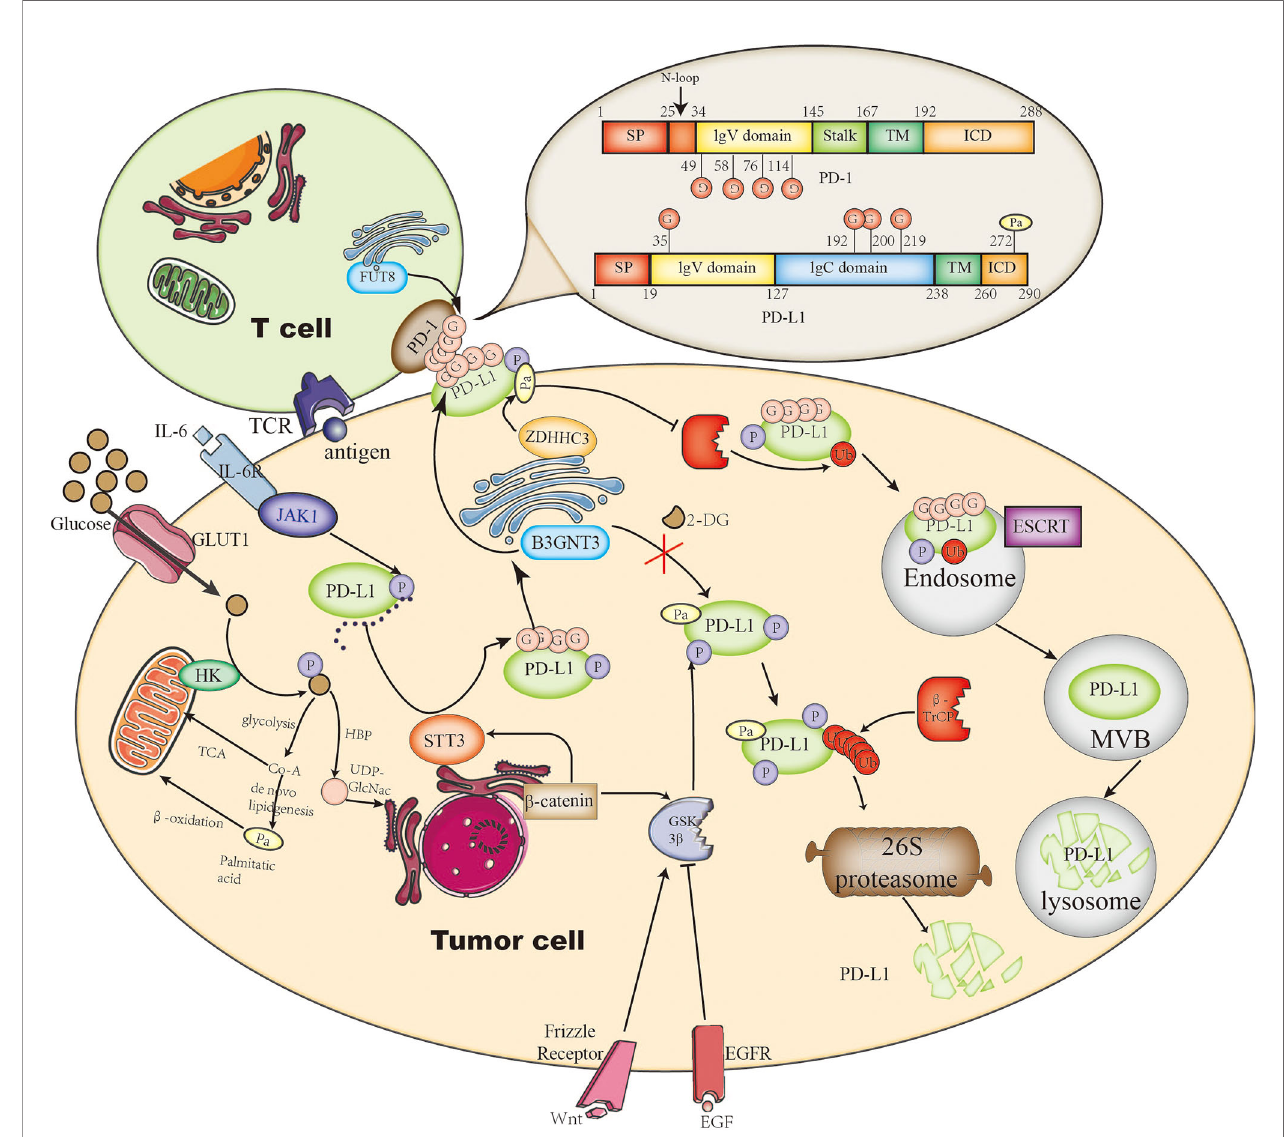
FIGURE 1 | The roles of glycosylation and palmitoylation of PD-1/PD-L1. In T cells, PD-1 is glycosylated by FUT8, leading to its stable expression on the cell surface and causing a stronger interaction with glycosylated PD-L1. On the other hand, PD-L1 is glycosylated or degraded through different pathways. It can be glycosylated by STT3 in ER or by B3GNT3 in the Golgi apparatus. Glycosylation helps to maintain its stability by preventing GSK3 b -dependent phosphorylation and downstream b -Trcp-mediated 26S proteasome degradation. In addition, PD-L1 palmitoylation catalyzed by ZDHHC3 stabilizes PD-L1 through blocking PD-L1 mono- ubiquitination, otherwise ubiquitinated PD-L1 will be sorted by endosomal sorting complexes required for transport (ESCRT) to the multivesicular body (MVB) for degradation. Glycosylation is affected by the branch glucose metabolism pathway HBP, which directly provides the glycosylation substrate (UDP)-GlcNAc. Palmitoylation is affected by the lipid synthesis which leads to palmitate acid